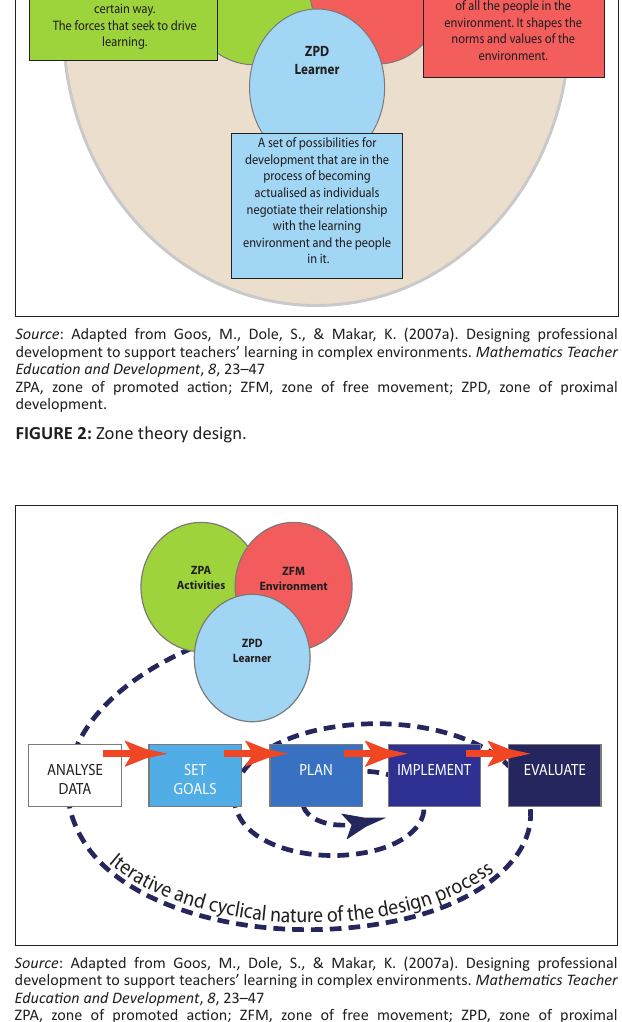
FIGURE 3: Iterative nature of the design.